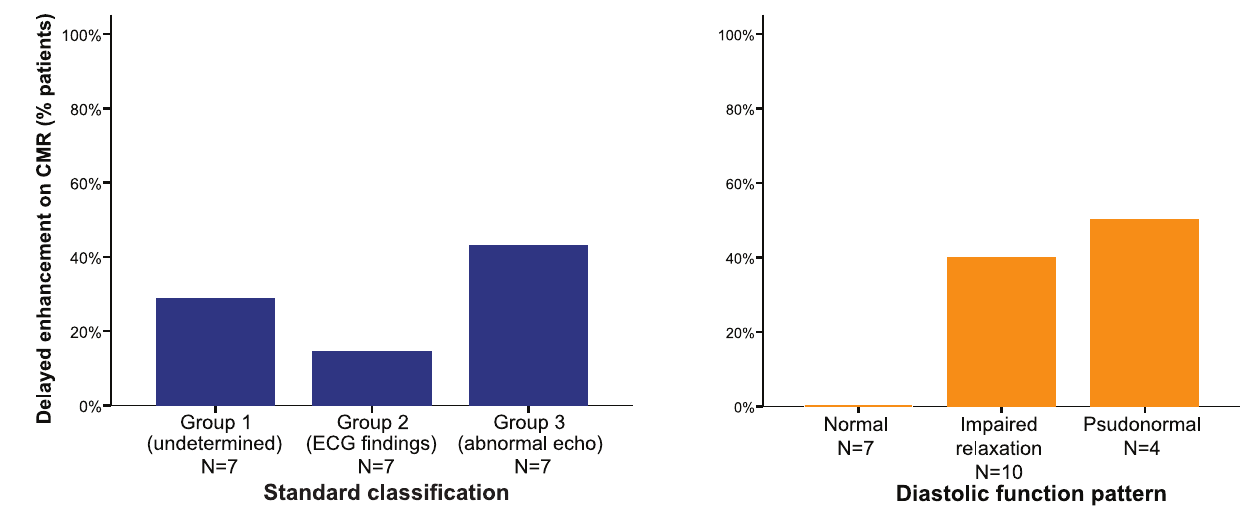
Figure 3. Delayed enhancement on CMR (observed cases/N) in Chagas diseases patients. A Conventional classification. B Classification based on diastolic function. CMR= Cardiac Magnetic Resonance; ECG= electrocardiogram; Echo= conventional